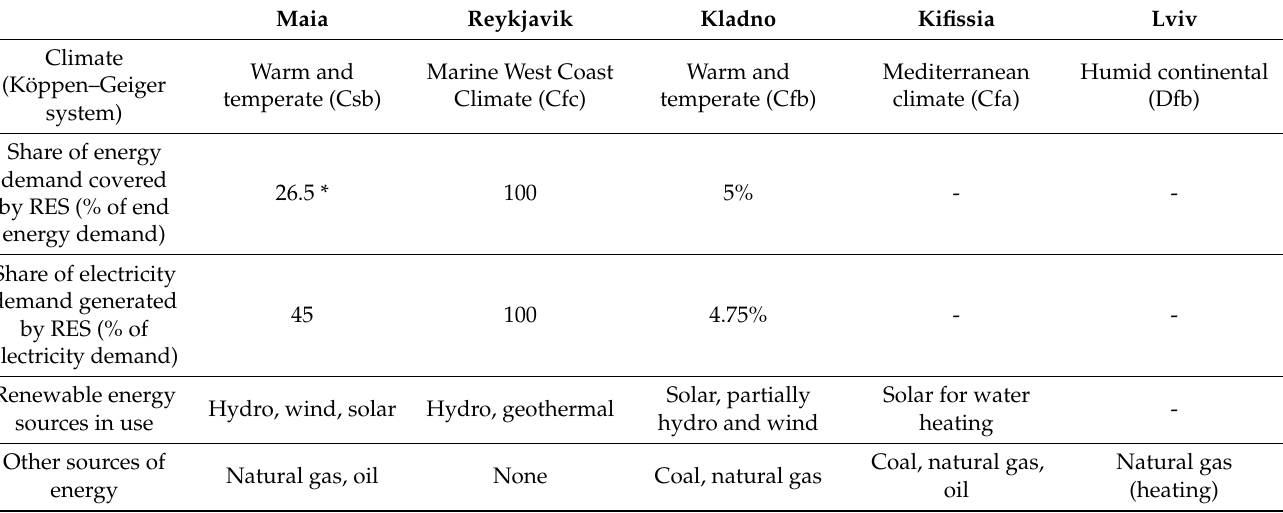
Table 1. Profile of the five Fellow Cities of Maia, Reykjavik, Kladno, Kifissia, and Lviv (improved and adapted from